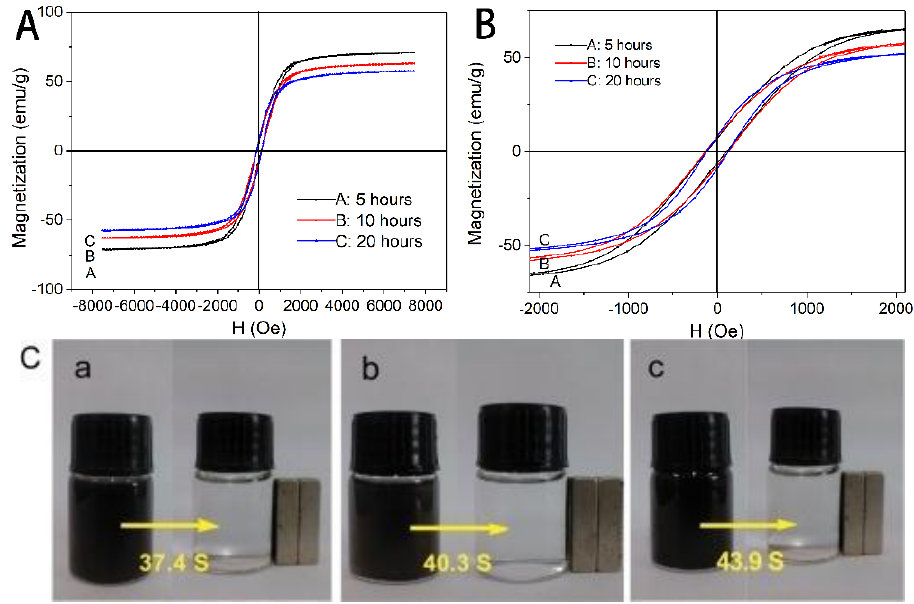
Figure 12. The hysteresis loops at T = 300 K of Fe 3 O 4 ( A ) and corresponding partly amplification images ( B ) with different reaction time ( a ) 5 h, ( b ) 10 h, ( c ) 20 h; ( C ) photograph showing magnetic isolation.